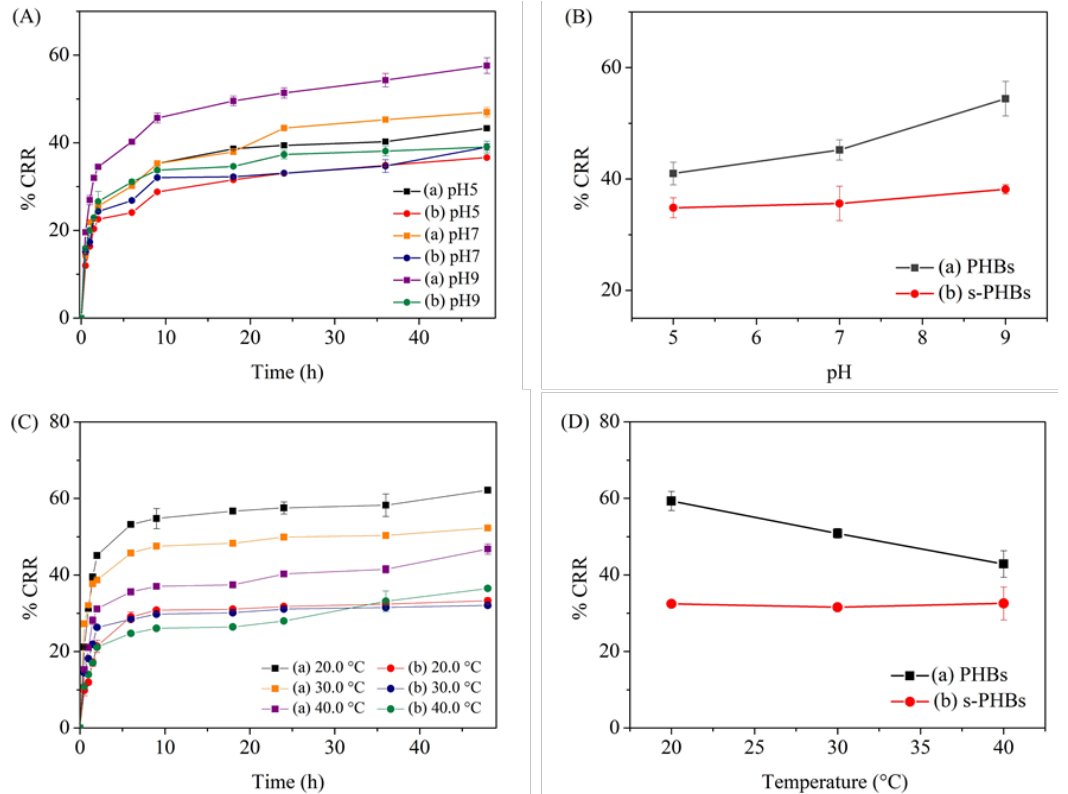
Figure 8. Effect of pH on phosphate release; ( A ) the cumulative release ratio and ( B ) their corresponding plots for phosphate release in the last 24 h of ( a ) PHBs and ( b ) s-PHBs at different pHs. Effect of temperature on phosphate release; ( C ) the cumulative release ratio and ( D ) their corresponding plots for average phosphate release in the last 24 h of ( a ) PHBs and ( b ) s-PHBs at different temperatures.